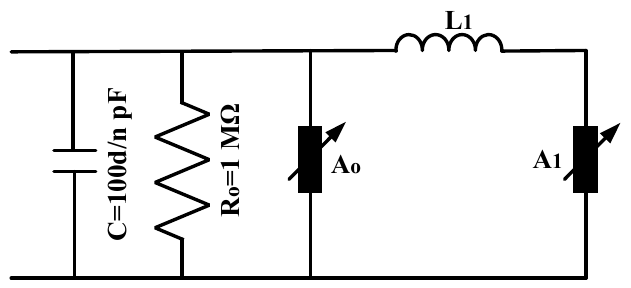
Figure 6. The Fernandez–Diaz model [13].